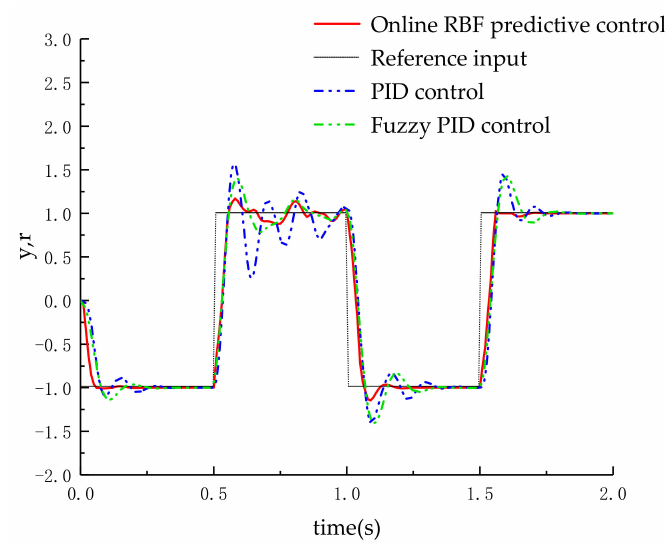
Figure 16. Comparison of control effects with interference signals.